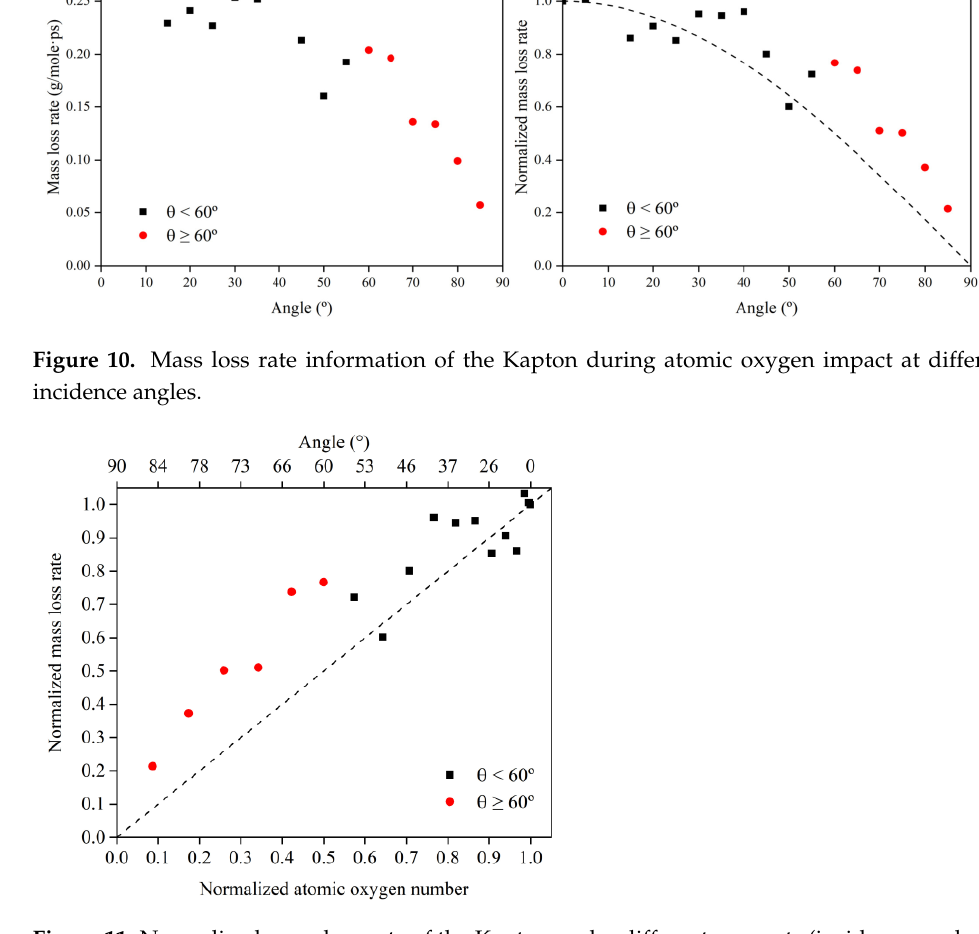
Figure 11. Normalized mass loss rate of the Kapton under different amounts (incidence angles) of impacted atomic oxygen.